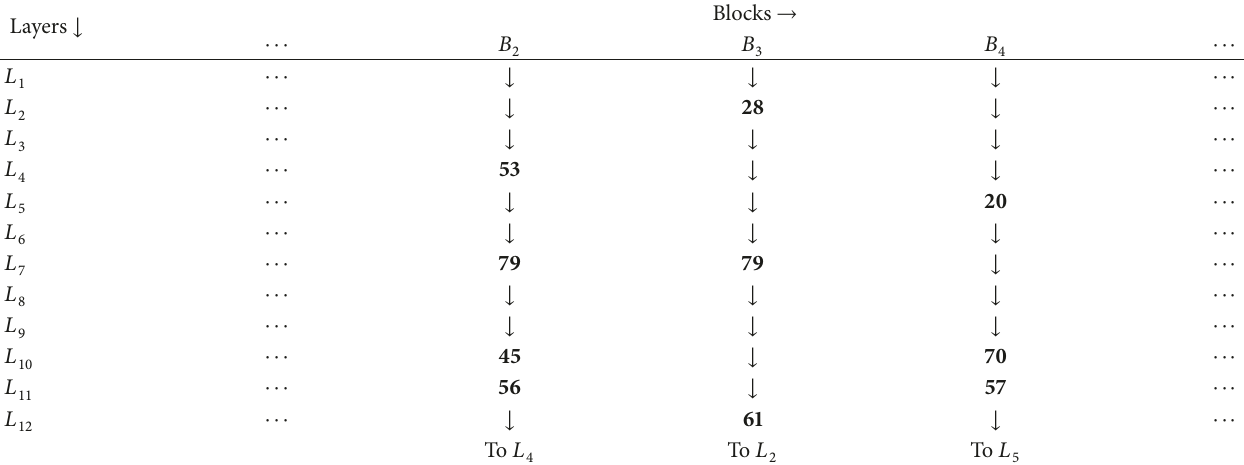
Table 3: Illustration of message passing in row-layered decoding in a section of the PCM H 𝑏 . Layers ↓